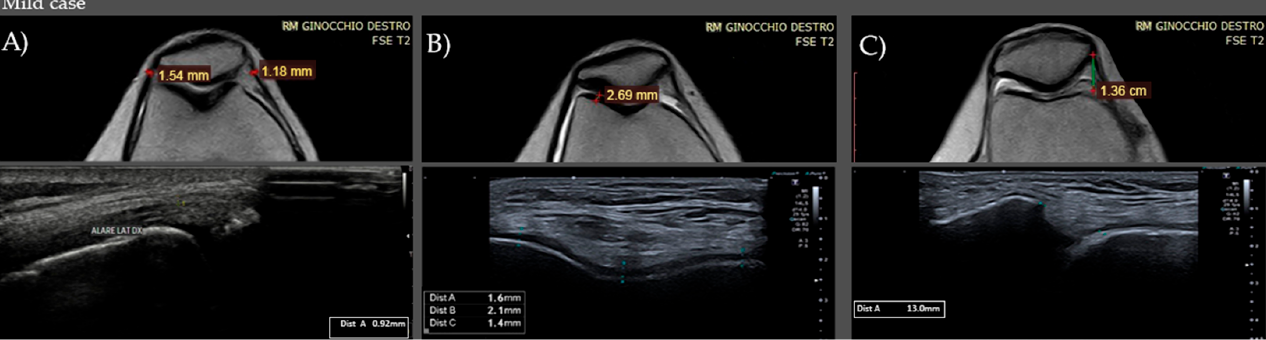
Figure 3. MRI and US values of retinacles ( A ) and cartilage ( B ) thickness and medial patello-femoral distance ( C ). Images of mild pathological cases.